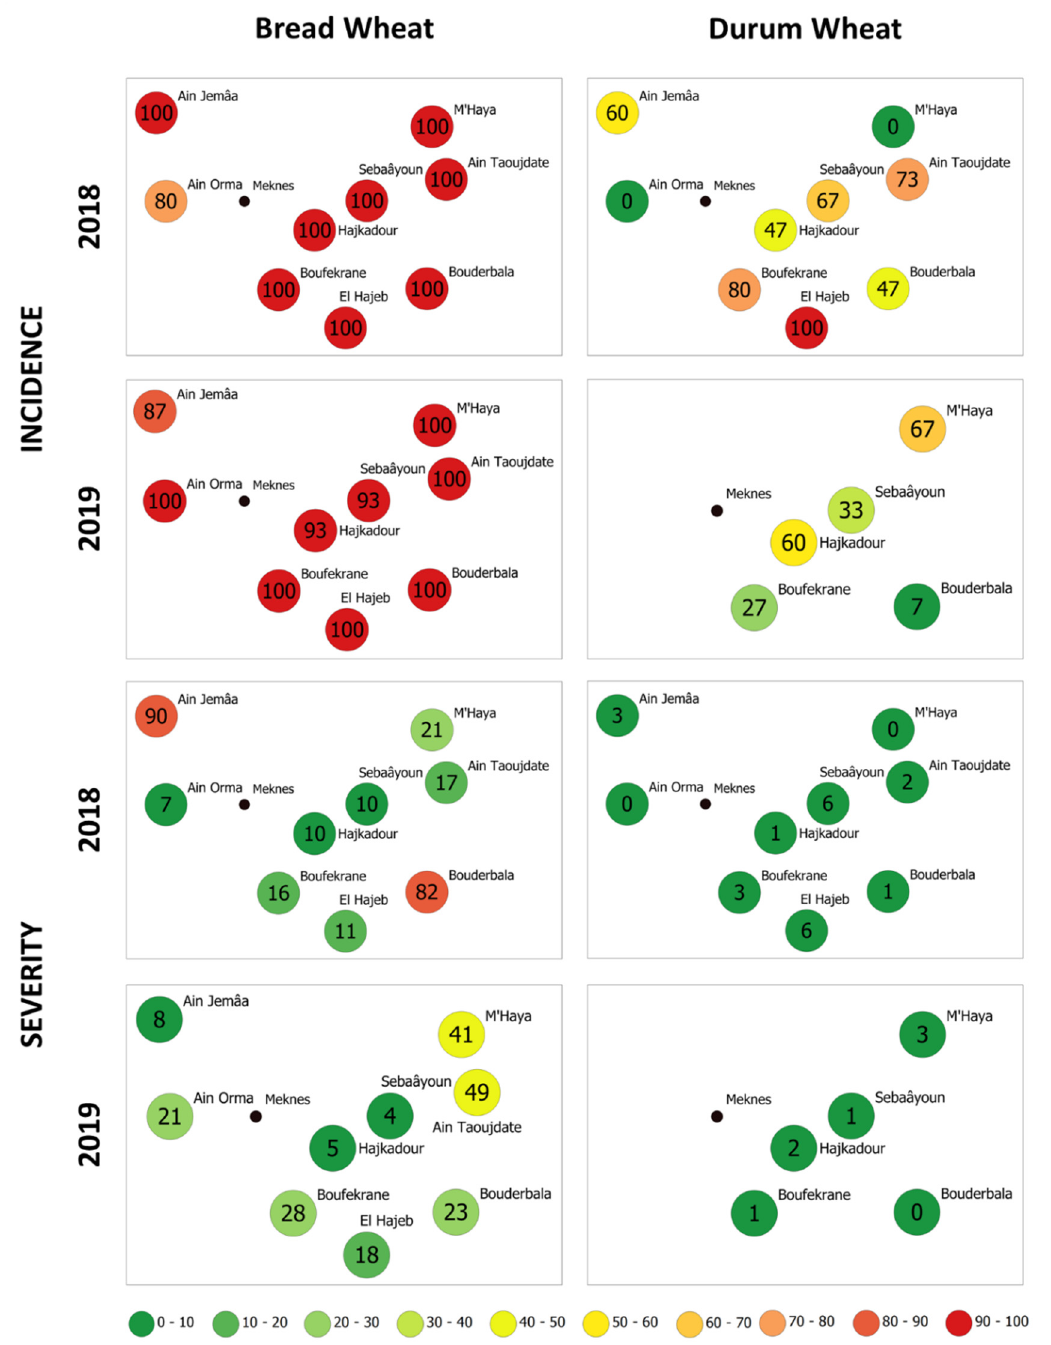
Figure 4. Maps of maximum percentages of wheat stripe rust incidence and severity (%) in bread and durum wheat at the surveyed sites in Morocco during the 2017 / 2018 and 2018 / 2019 cropping seasons. The position of the circle corresponds to the site coordinates as presented in Figure 1.